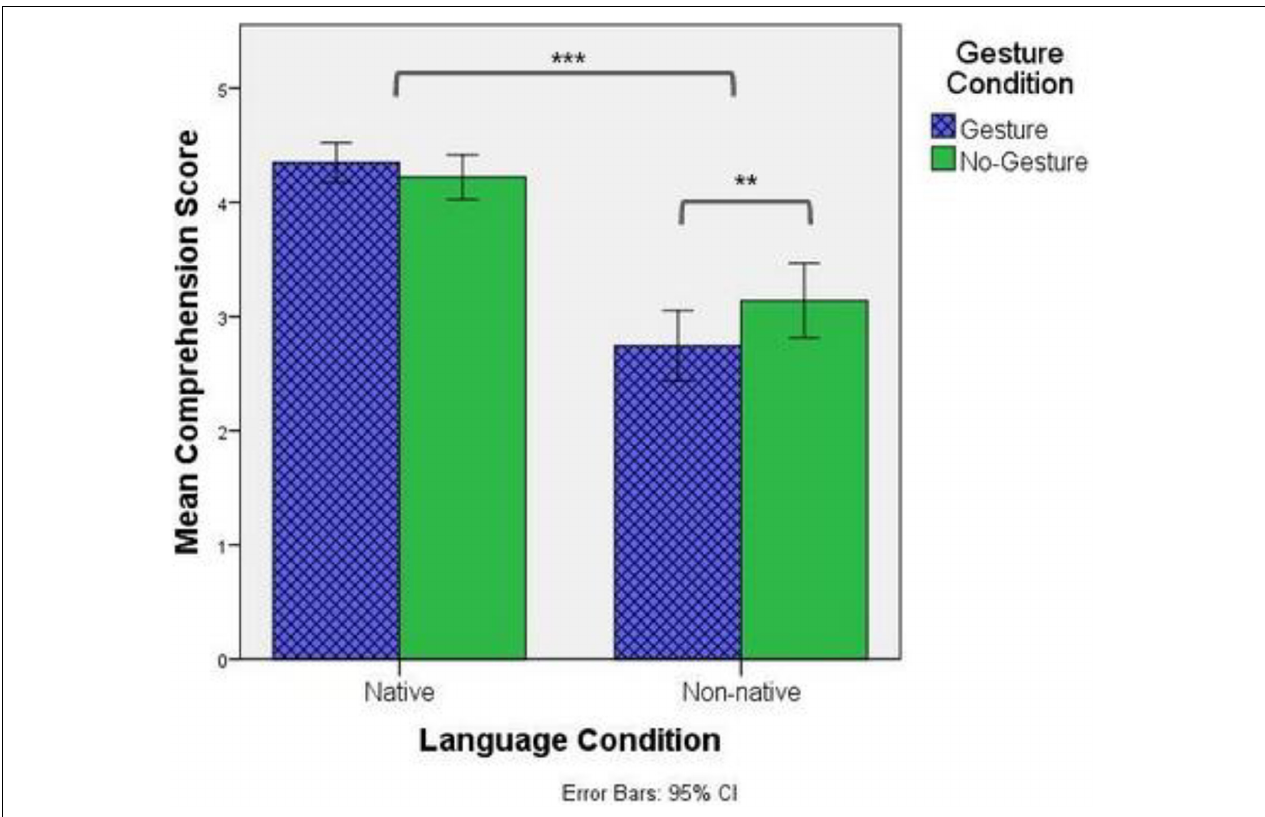
FIGURE 4 | Mean comprehension scores by Language and Gesture condition. “**” Refers to a p -value less than 0.01, while “***” refers to a p -value less than